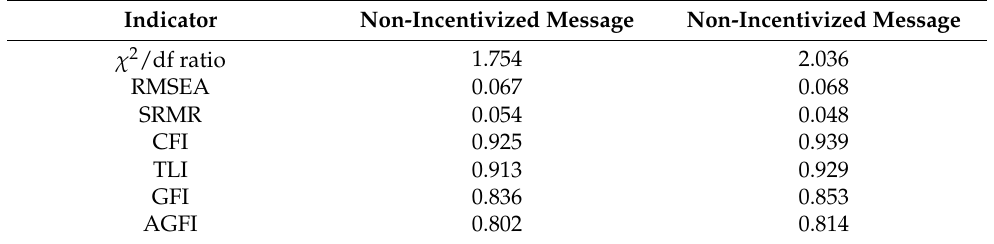
Table 4. Goodness-of-fit indicators for the confirmatory factor analysis in each